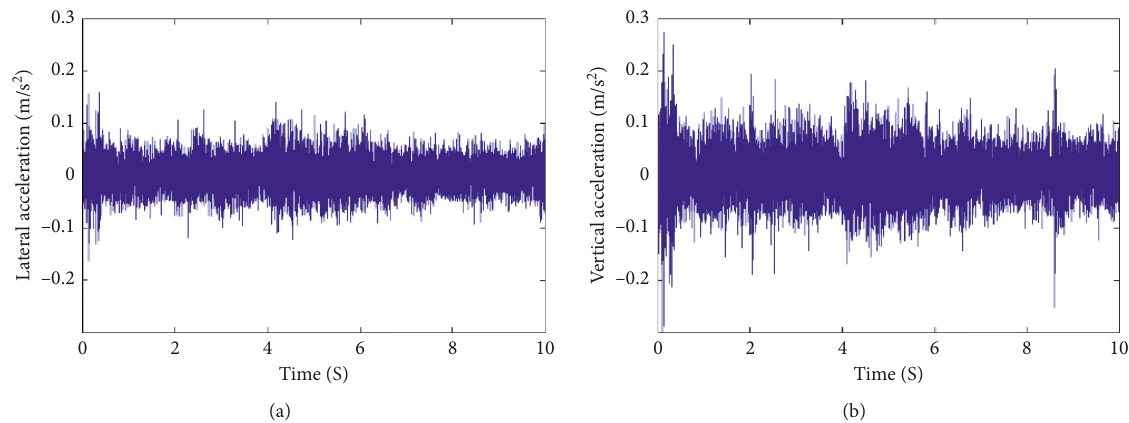
Figure 10: Acceleration data of car body underframe in time domain (350 km/h). (a) Lateral. (b) Vertical.